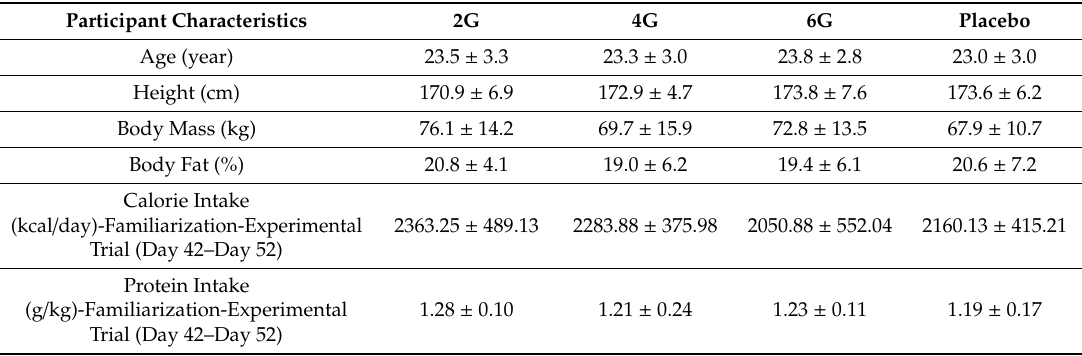
Table 1. Participant descriptive for each supplement group. Participants were randomly assigned (n = 8 / group; 4 males and 4 females per group) to their designated supplement group. No significant di ff erences ( p > 0.05), as determined via a one-way analysis of variance, were noted between groups for age, height, body mass, body fat percentage, or calorie or protein intake from day 42–day